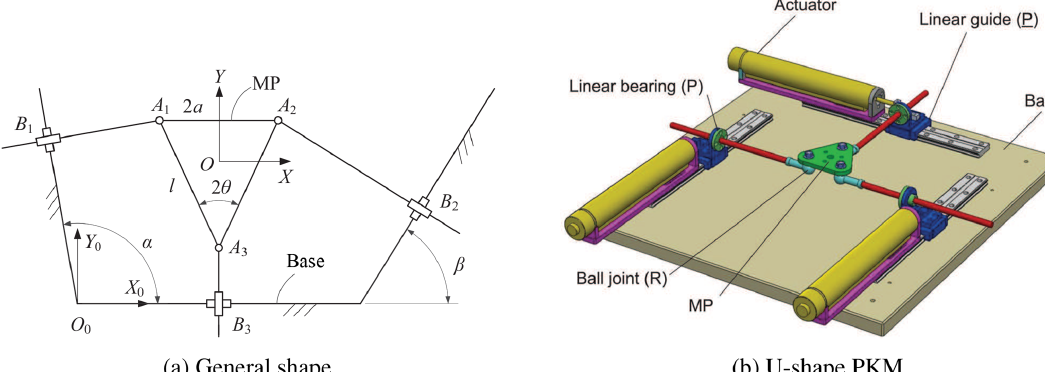
Figure 1. The 3-PPR parallel kinematics machine.